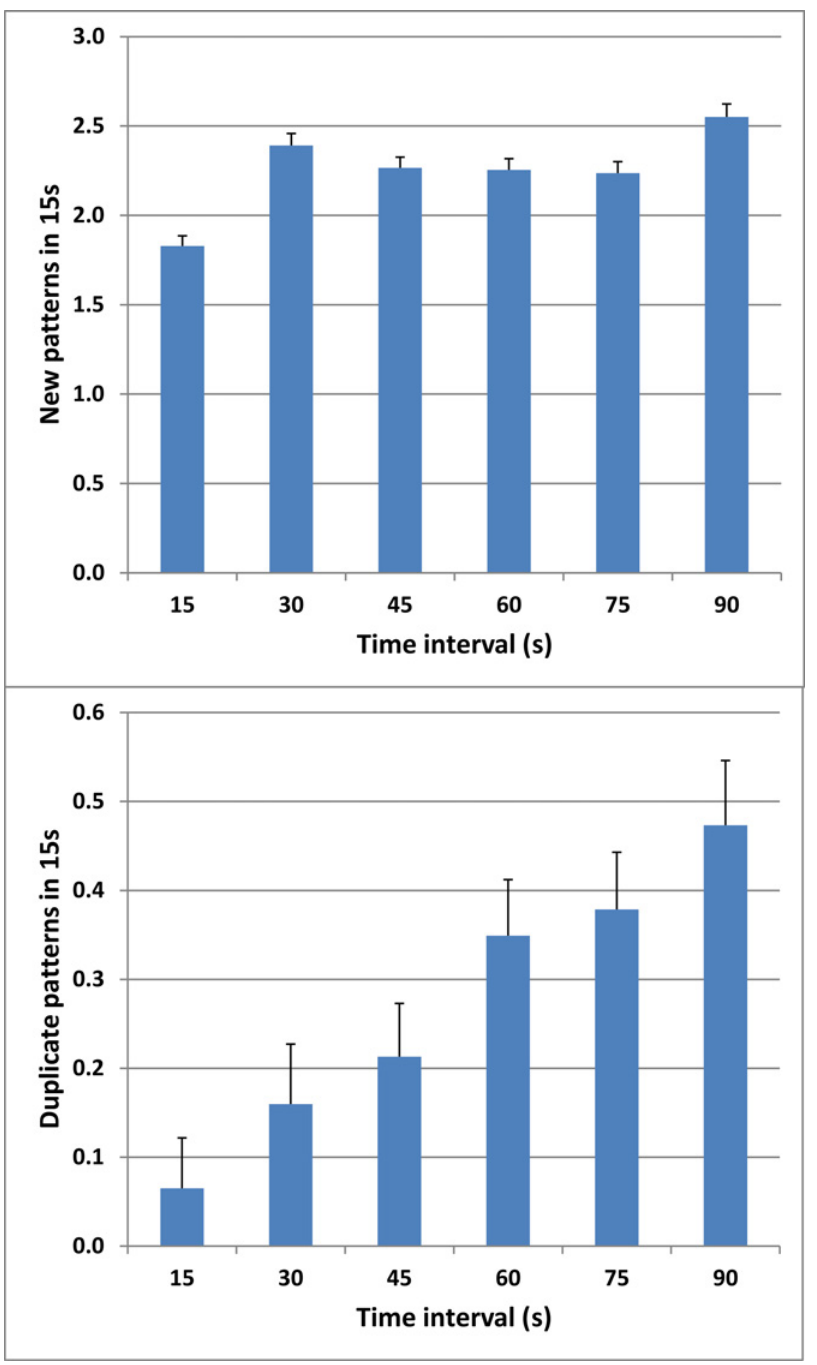
Fig 5. Pattern production rate. The number of unique patterns (top) and repeated patterns (bottom) produced over successive 15 s intervals by the participants in Experiment 1. Error bars show standard errors of the